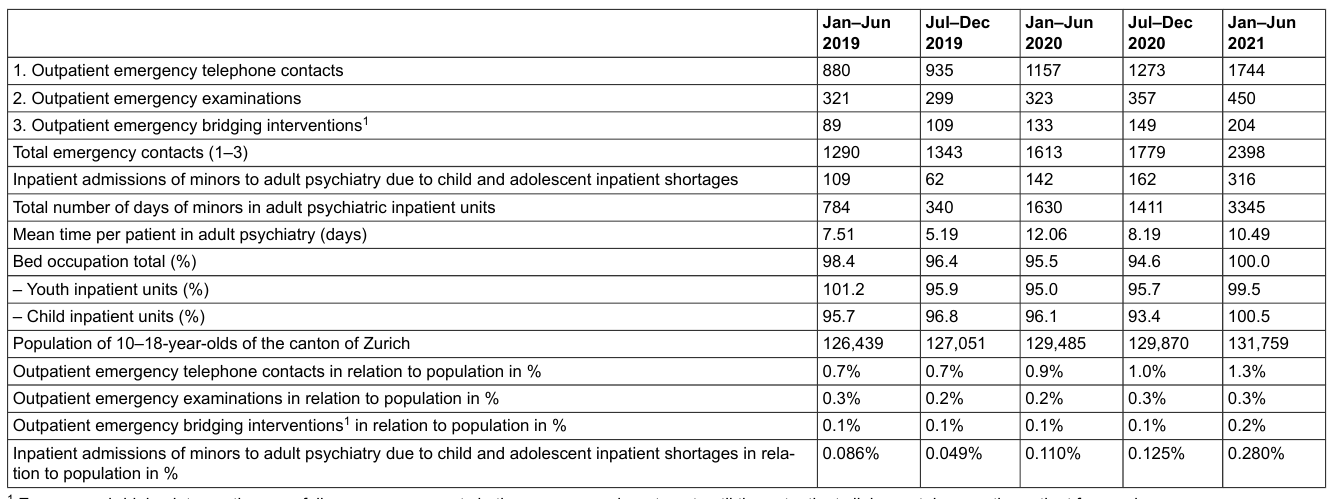
Table 1: Emergency contacts with the Central Emergency Service of the state of